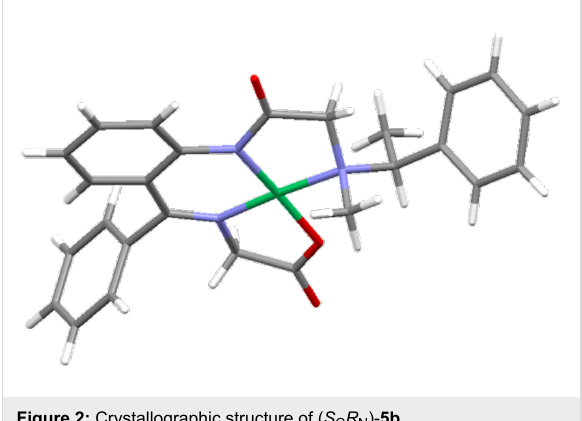
Figure 2: Crystallographic structure of ( S C R N )- 5b .